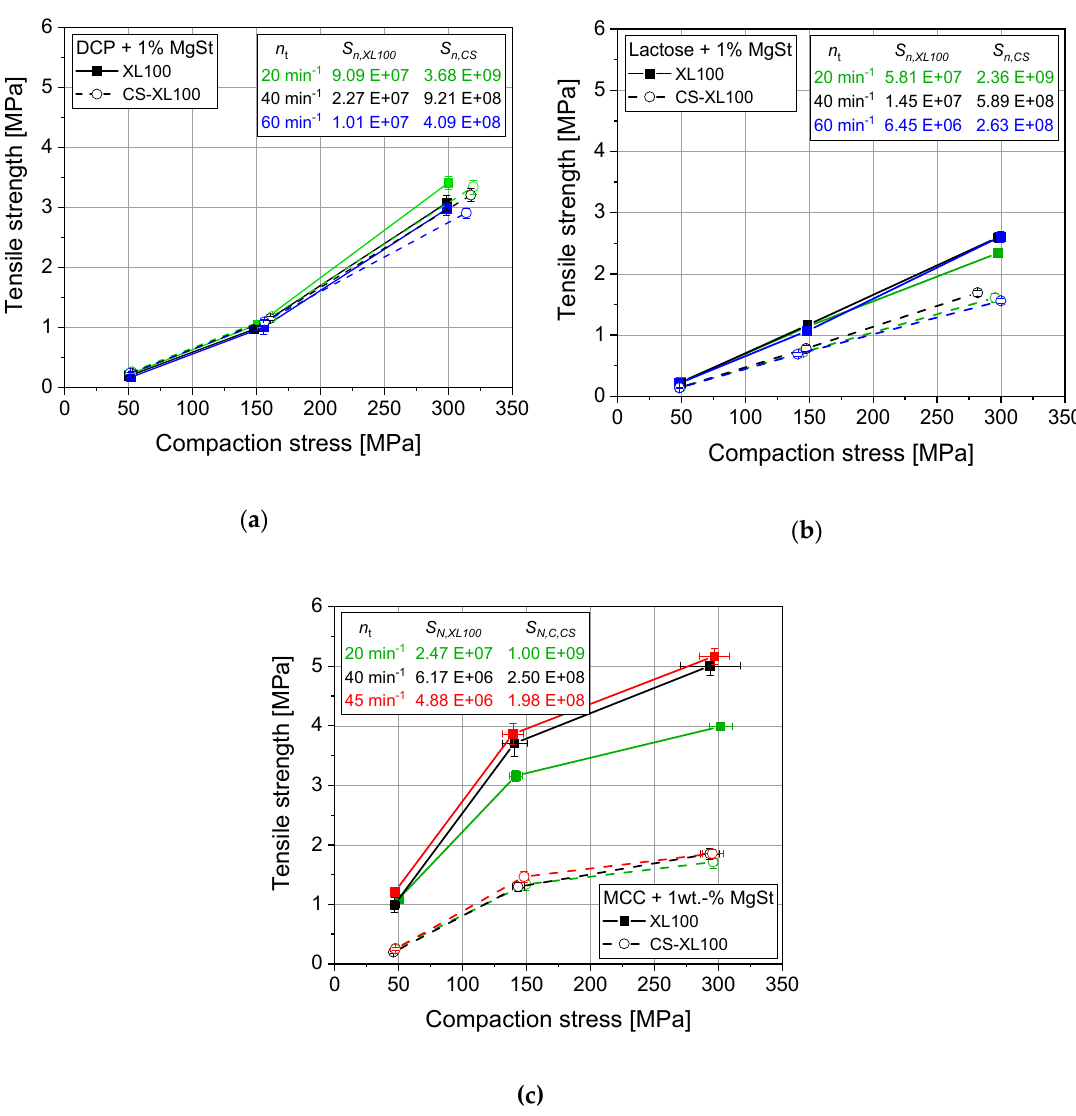
Figure 6. Comparison of tabletability profiles of DCP + 1 wt.-% MgSt ( a ), lactose + 1 wt.-% MgSt ( b ), and MCC + 1 wt.-% MgSt ( c ) on an XL100 as well as its simulation profiles applied on a CS with different (simulated) turret rotation frequencies, applying paddle rotation frequencies of n p,XL100 = 20 min − 1 and n p,CS = 272 min − 1 to achieve convenient filling, applying 9 mm punches. n = 10 .